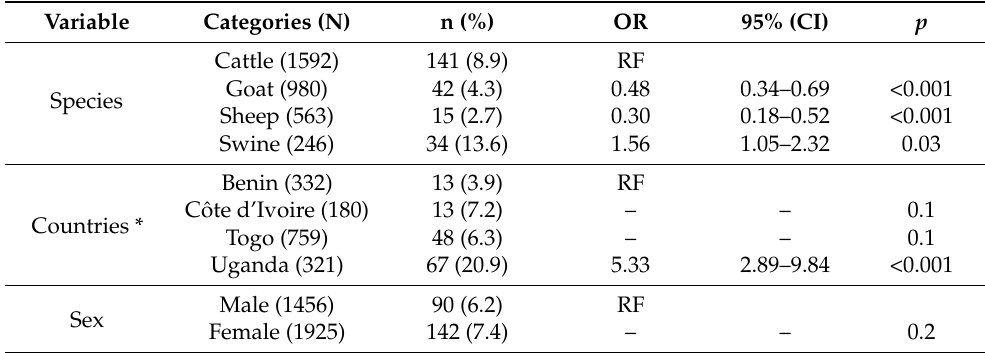
Table 2. Factors associated with anti-IDV seropositivity rates among cattle, sheep, goat and swine in four countries of West and East